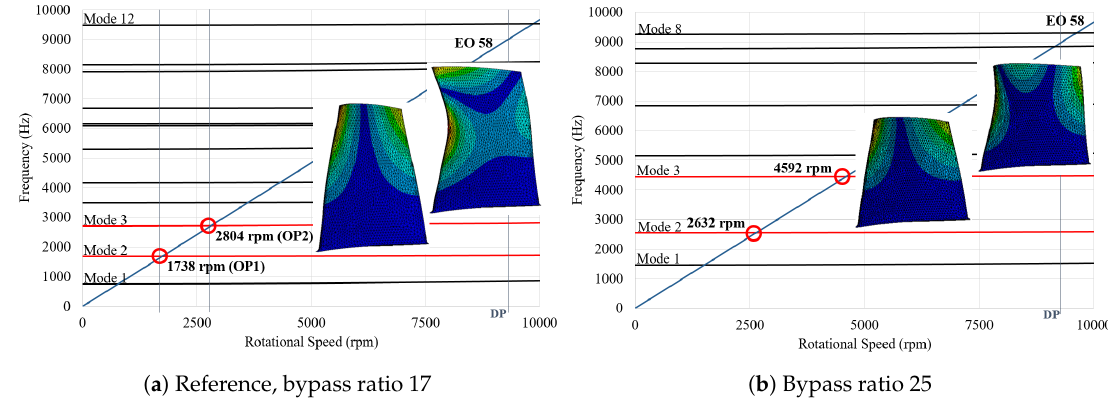
Figure 7. Campbell diagram of rotor 1 with eigenmodes—Modes 2 and